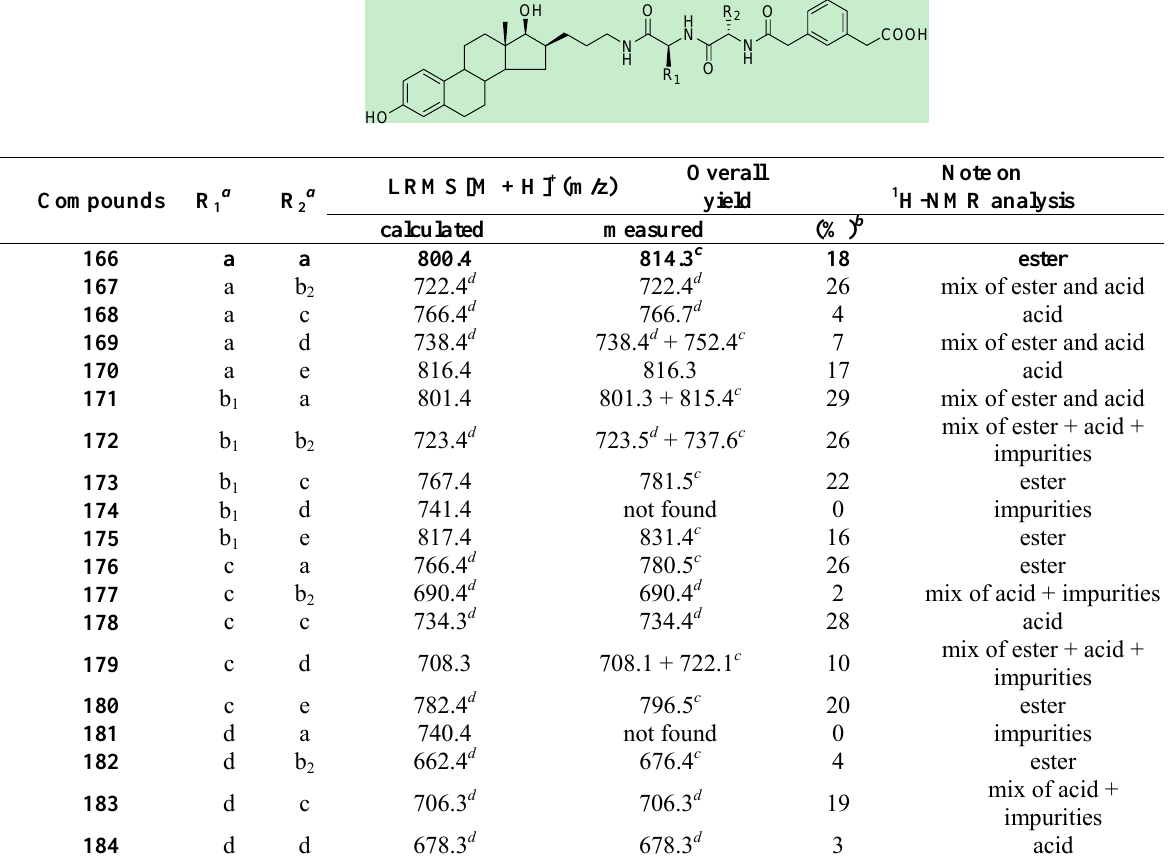
derivatives 166–190 2